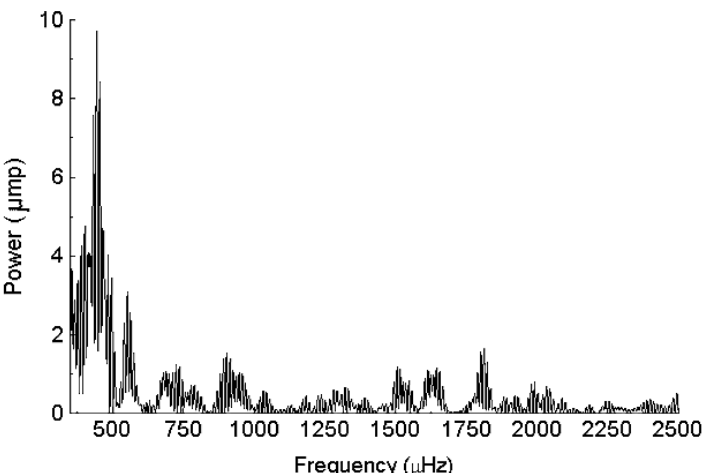
Fig. 7. FT of NGC 246 merged from the consecutive nights, September 17–18 at IAC80.